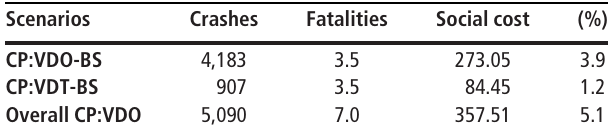
Table IV Crashes, fatalities and social cost of